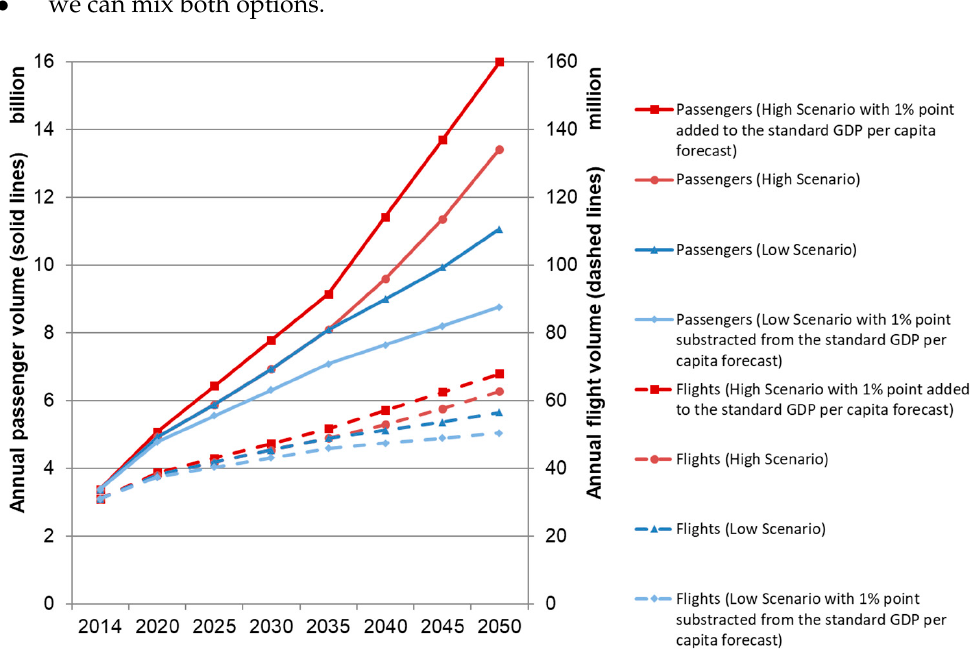
Figure 12. Results of the passenger demand and flight volume forecast.